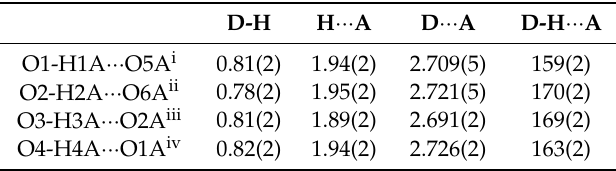
Table 3. Hydrogen bonding geometry (Å, ˝ ) for 3